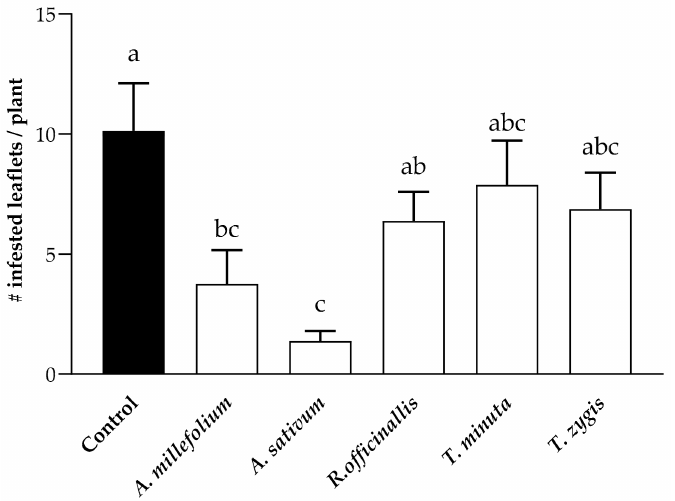
Figure 2. Number (mean ± SE) of T. absoluta -infested leaflets on tomato plants sprayed with different PEOs under greenhouse conditions. Bars marked with different lower-case letters are significantly different (Tukey’s test; p ≤